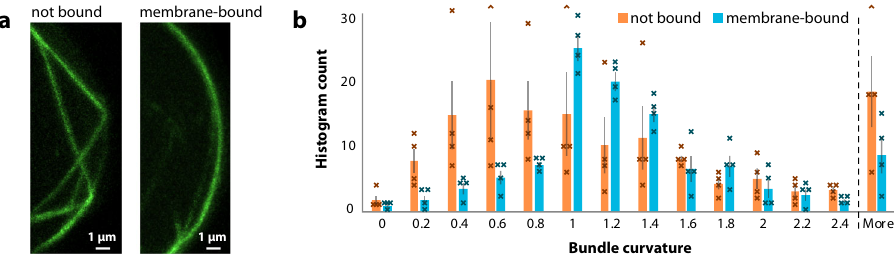
Fig. 2 Membrane attachment affects curvature of actin bundles. a Each image shows a section of the membrane of a GUV with actin bundles cross-linked by fascin (2 µ M actin and 0.2 µ M fascin). Actin is in green. Unattached bundles have long sections with low curvature, while membrane-bound bundles follow the curvature of the membrane. b Distribution of curvatures for actin bundles in vesicles with and without membrane binding. n = 4 GUVs for each condition. Confocal z -stacks were converted into 3D information (see Fig. 1d). Bundles were then divided into small segments and their curvature was measured. Curvature is normalized to membrane curvature, so that a curvature of 1.0 equals the curvature of the membrane. Data are shown as mean values with individual histogram counts and SEM. More details about the analysis can be found in the Supplementary